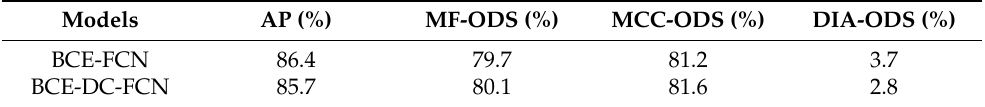
Figure 11. The performances of FCN models trained with different losses. Table 3. The mean values of evaluation metrics computed from FCN models trained with differ- ent losses.